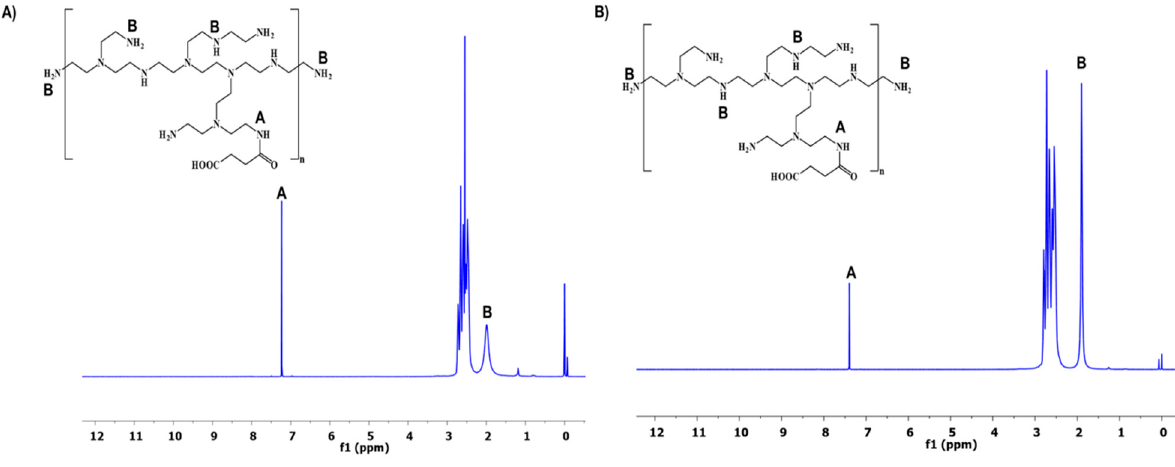
Figure 3. 1 H NMR spectra of PEI–DQA: PEI (10 kDa) ( A ) and PEI (25 kDa) ( B ); the spectrum of DQA ( C ). 3.2. pDNA Complexation Capacity The formulation of PEI–DQA/TAT/pND1 systems was elaborated using a dropwise precipitation method. First, PEI–DQA solution was added to pDNA solution for 1 min, after which TAT peptide solution was added. Electrostatic interactions are the main force that allows the encapsulation of pDNA by PEI–DQA and TAT. These interactions occur due to the negative charges on pND1 that bind to the positive charges on both PEI and TAT, forming nanoscale systems. The interaction strength is dependent on the N/P ratio considered at the formulation step, and the higher the ratio, the greater the availability of positive charges to interact with pND1. Moreover, in previous research by our team, the cytotoxicity of TAT/pDNA complexes was evaluated as a function of the N/P ratio on both fibroblasts and HeLa cells [26]. The results demonstrated that TAT/pDNA com-